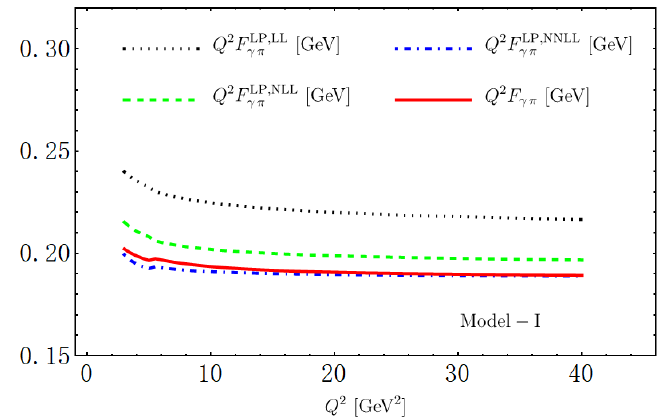
Figure 4: Theory predictions of F γπ ( Q 2 ) at the LL (black dotted), NLL (green dashed), and NNLL (blue dot-dashed) order in QCD, respectively, adopting Model I in Eq. (20) ) . The red solid curve further includes the as the non-perturbative input for φ π ( x , µ 0 subleading power contributions evaluated in [ 8,38 ]